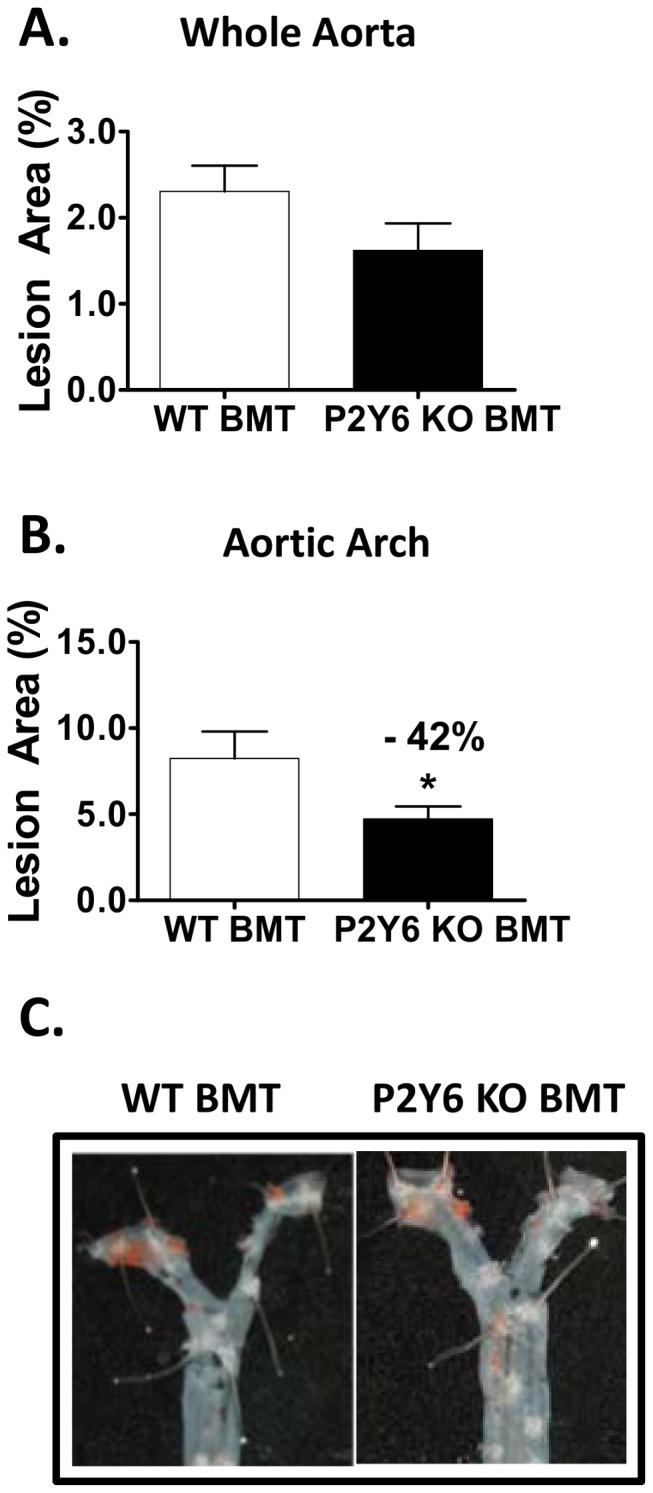
Atherosclerosis development with P2Y6-deficient bone marrow reconstitution.
A) Quantification of en face lesion area with oil red O staining in the whole aorta from the ascending aorta to the iliac bifurcation and B) aortic arch. C) Representative images of aortic arch atherosclerosis. Group sizes: n = 9 P2Y6 WT transplanted mice; n = 14 P2Y6 KO transplanted mice. Significance vs. control: *p<0.05. Not significant, n.s.